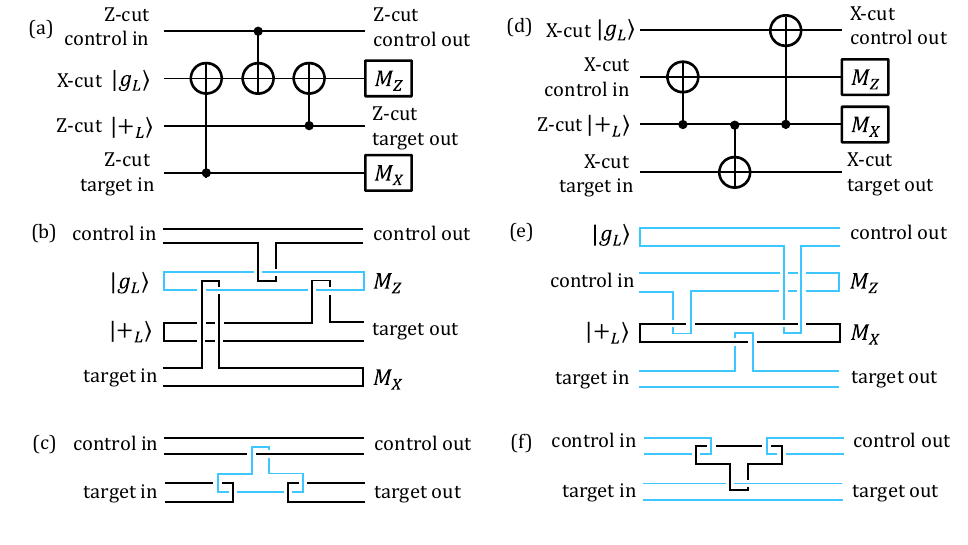
Figure 40: (a) Logical CNOT between two Z-cut qubits. The control, target in, and the second 〉 ) are all Z-cut qubits, while the first ancilla is an X-cut qubit. The logical CNOTs ancilla (in | + L are all between Z- and X-cut qubits, generated by braiding transformations. The measure outcomes M and M signal how the output state should be interpreted, as described in the Z X main text. (b) Simplified representation using braids, with black lines for Z-cut qubits and blue (light) lines for the X-cut qubit. There are a pair of lines for each logical qubit, one line for each qubit hole. The two lines join when a logical qubit is created or measured. (c) Even more condensed representation. (d) Logical CNOT between two X-cut qubits. The control, target in, and the first ancilla are all X-cut qubits, while the second ancilla is a Z-cut qubit. The logical CNOTs are all between X- and Z-cut qubits, generated by braiding transformations with the Z-cut as the control. The measure outcomes M and M signal how the output state should Z X be interpreted. (e) Simplified representation, with black lines for the Z-cut qubits and blue (light) for the X-cut qubit. (f) Even more simplified representation. Figure from Ref. (Fowler, Mariantoni, Martinis and Cleland,